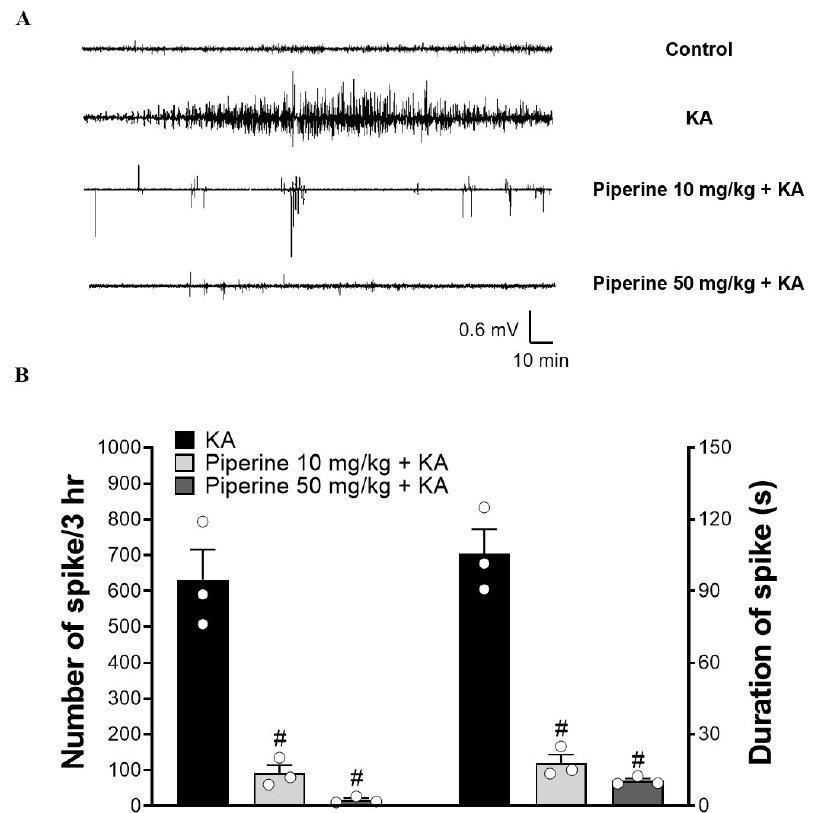
Figure 2. Effect of piperine pretreatment on electrographic seizures in rats with KA. ( A ) Representative EEG traces show epileptic bursts within 3 h. ( B ) The epileptic bursts are presented as the mean number and mean duration of seizure spikes. Data are presented as the means ± S.E.M. (n = 3). # p < 0.001 versus the KA group (ANOVA/Scheffé).